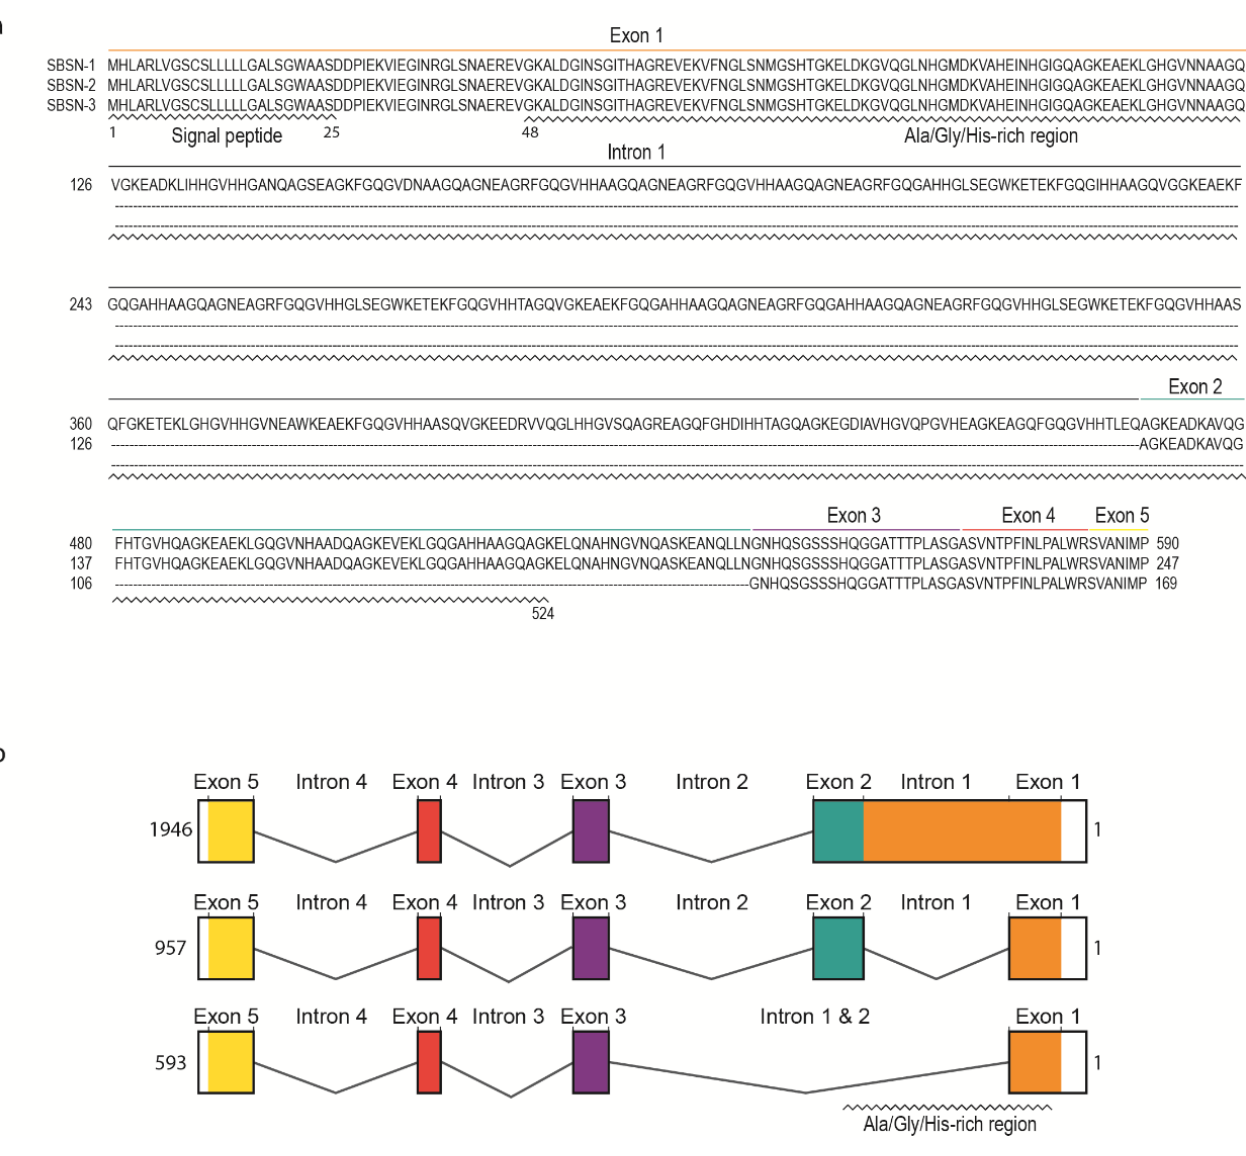
Figure 2. The sequences of SBSN isoforms. ( a ) The amino acid sequences of human SBSN isoforms. ( b ) The gene organization of human SBSN isoforms.